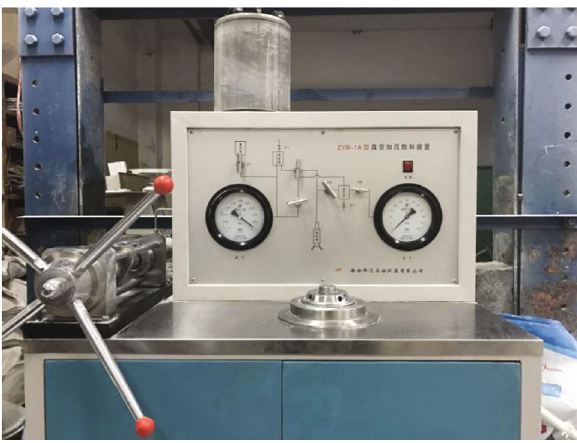
Figure 5: Vacuum saturation device